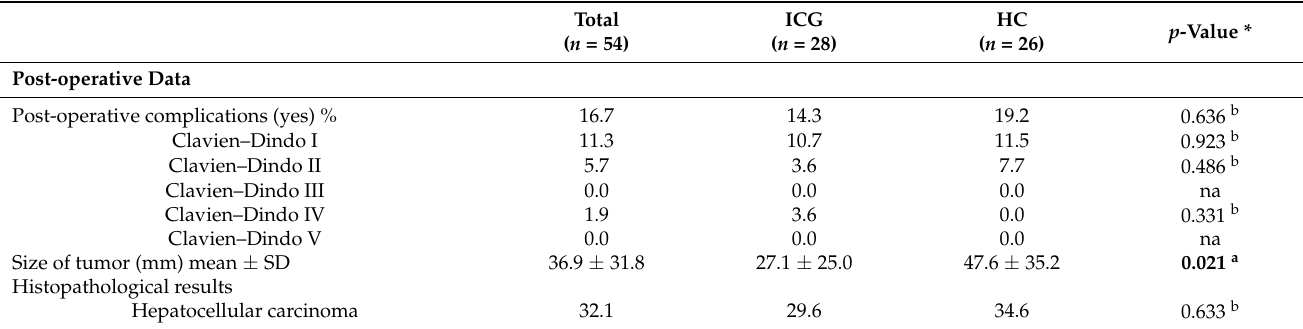
Table 2. Post-operative data and histological results of the comparison of patients who underwent RALS with and without obtaining preoperative intravenous